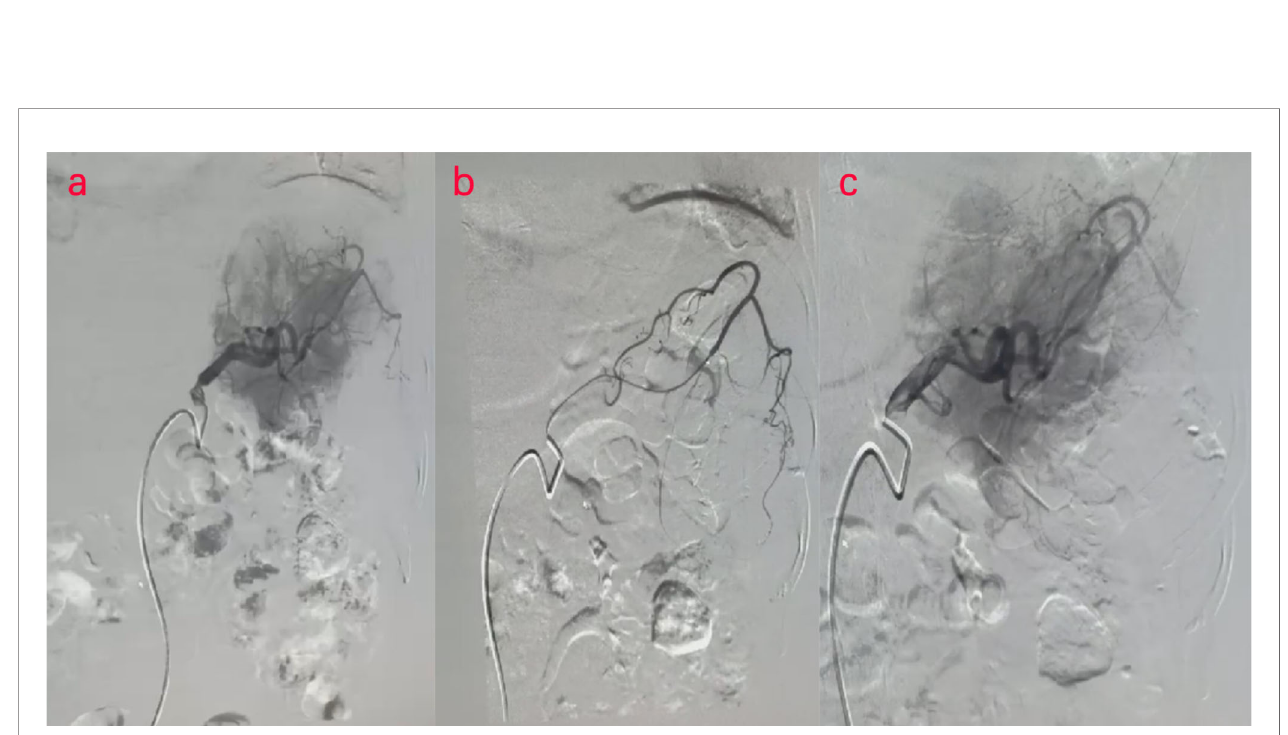
FIGURE 2 | (A – C) Digital subtraction angiography (DSA) examination of the patient. DSA images show splenic embolism in the